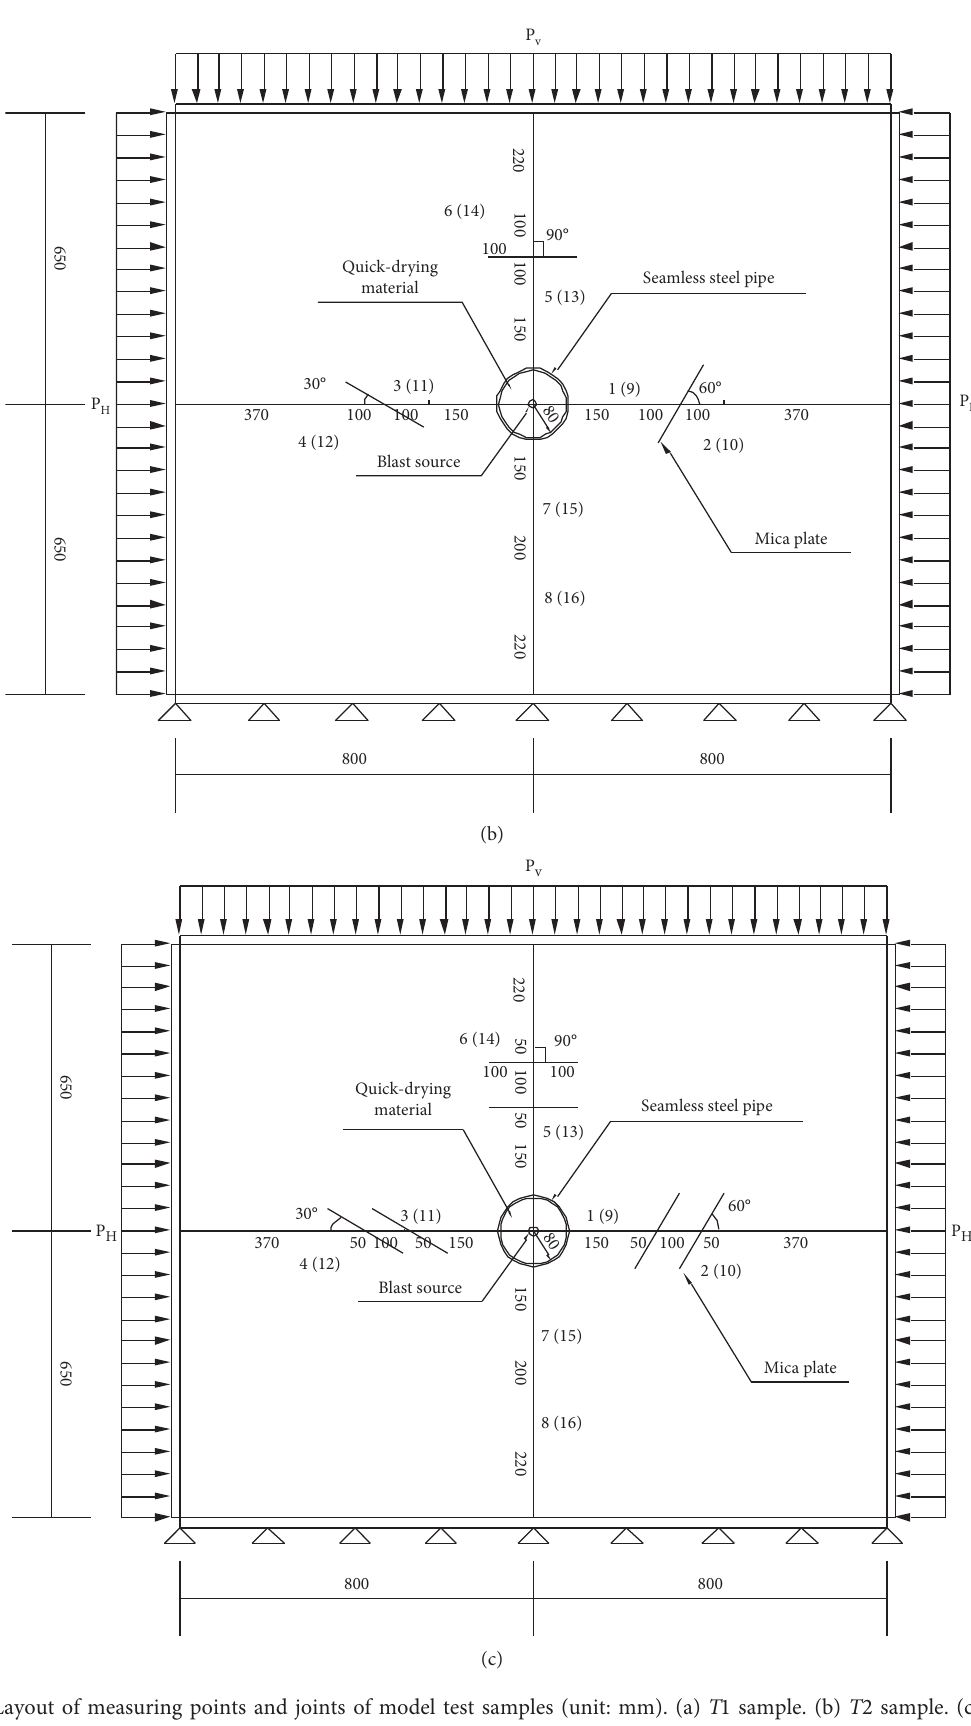
Figure 4: Layout of measuring points and joints of model test samples (unit: mm). (a) T 1 sample. (b) T 2 sample. (c) T 3